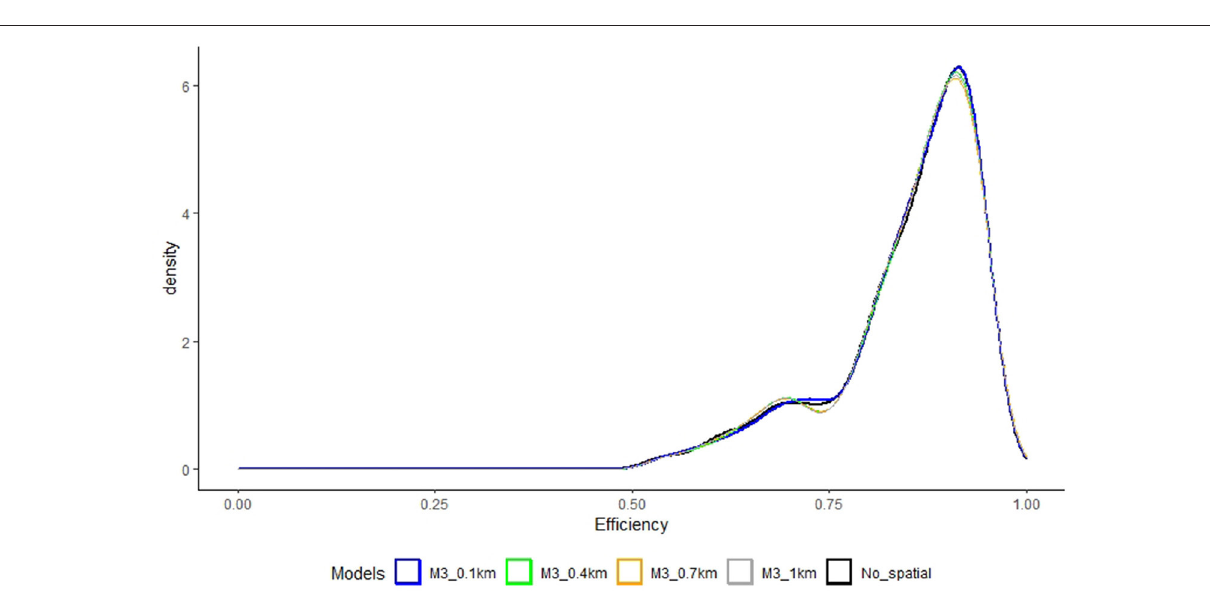
FIGURE 7 | Model 3 vs. non spatial: Farm technical efficiency distribution for rainfed farms at different cut-off